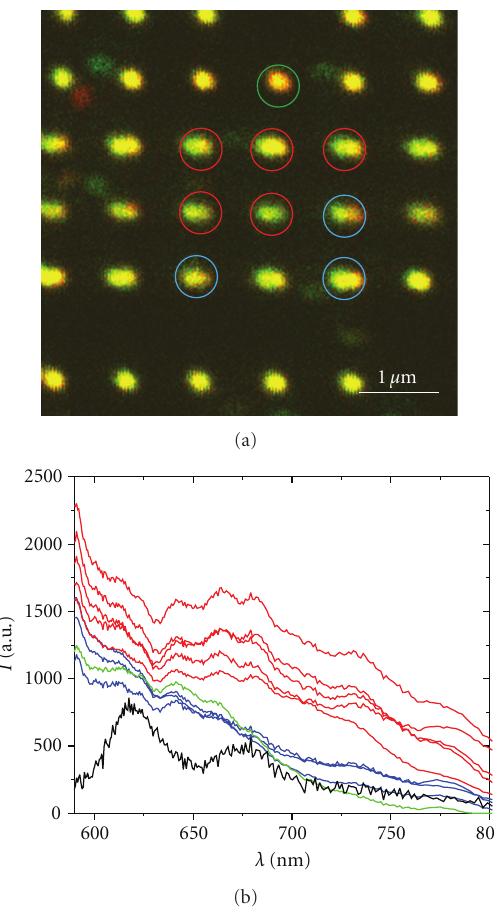
Figure 11: (a) Fluorescence image of a nanoantenna array with low concentration of perylene molecules. Bright spots indicate the positions of nanoantennas. First two rows and the lowest row are monomer antennas, while the middle three rows are dimer antennas. (b) Fluorescence spectra for eight dimer positions and one monomer position from the image in (a). The spectra with red lines correspond to red-encircled spots in the image, blue curves to the blue-encircled spots, and the green curve to the monomer position. The black curve indicates a typical perylene fluorescence spectrum recorded for a single molecule outside the nanoantenna